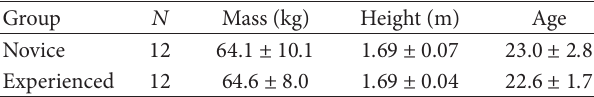
Table 1: Subject demographics (mean ± standard